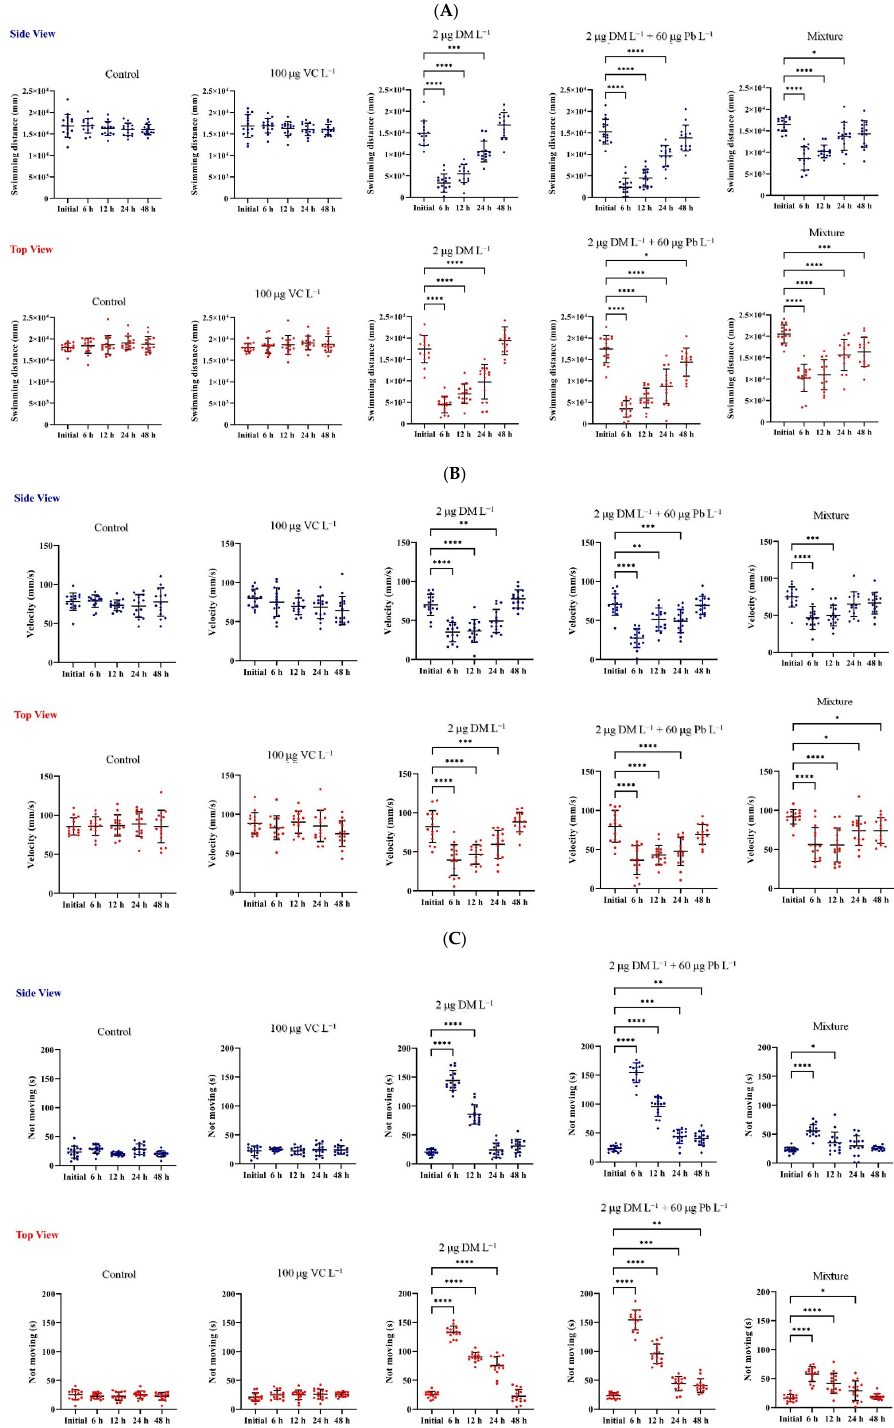
Figure 2. 3D locomotor activity assay for control and treated groups with 100 μ g VC L − 1 , 2 μ g DM L − 1 , 2 μ g DM L − 1 + 60 μ g Pb L − 1 and mixture of VC, Pb and DM. The graphs show ( A ) the total distance in the 3D space covered by the zebrafish (mm), ( B ) the velocity (mm/s) and ( C ) freezing duration (s) under the condition of no exposure and exposure to chemicals. Each dot represents an individual zebrafish ( n = 15 each experimental group). Data were expressed as mean ± SD. Statis- tically significant differences are denoted by * p < 0.05, ** p < 0.01, *** p < 0.001, **** p < 0.0001 (one-way ANOVA, followed by a Dunnett’s multiple comparisons test).